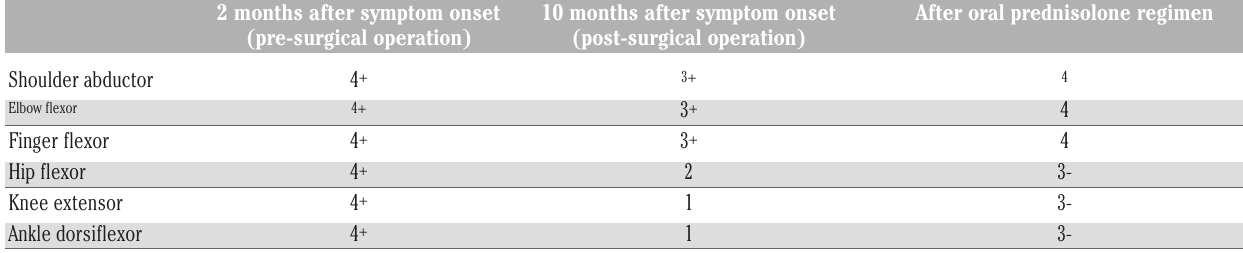
After oral prednisolone regimen